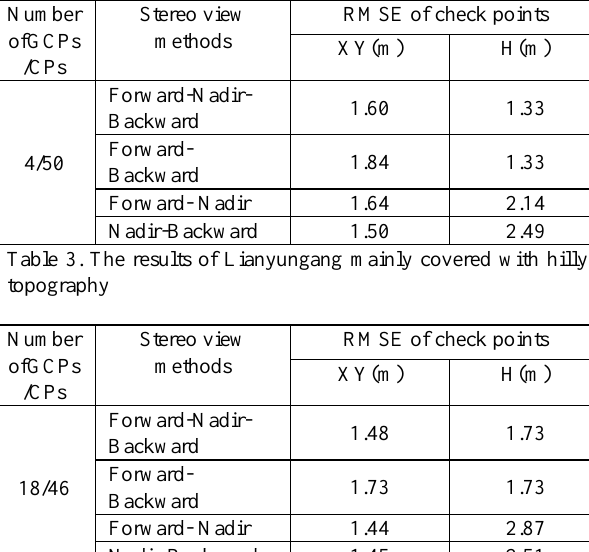
Table 4. The results of Tianjin mainly covered with flat